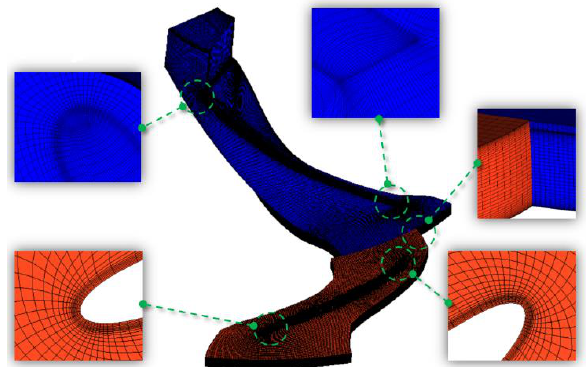
Figure 7. The grid schematic diagram of the impeller–diffuser fluid domain.